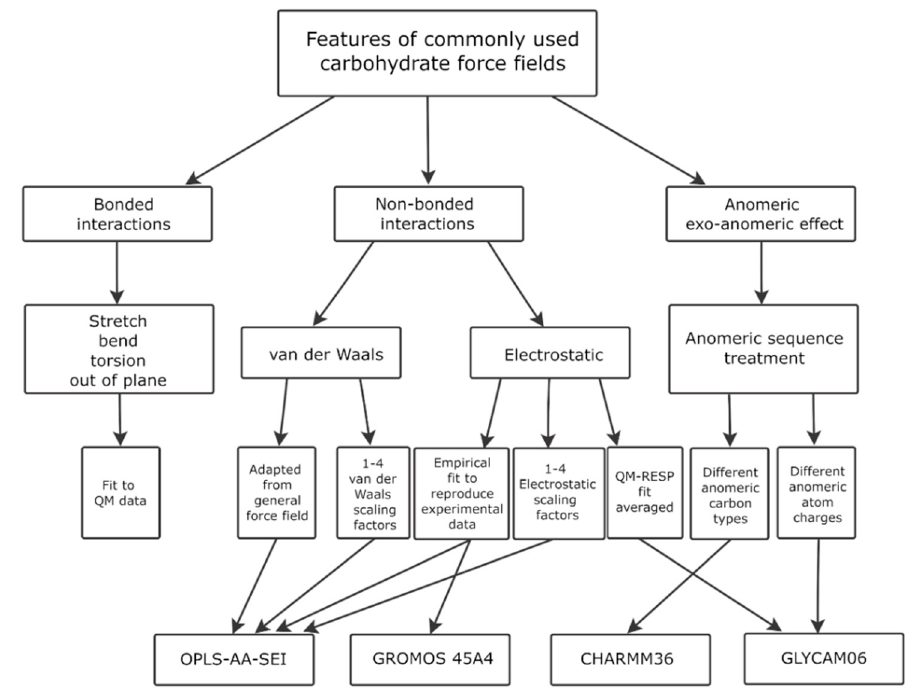
Figure 5. Digest of the most commonly used carbohydrate force fields with parameterization protocol comparison. Reproduced with permission from [138], © 2020 Elsevier Inc.